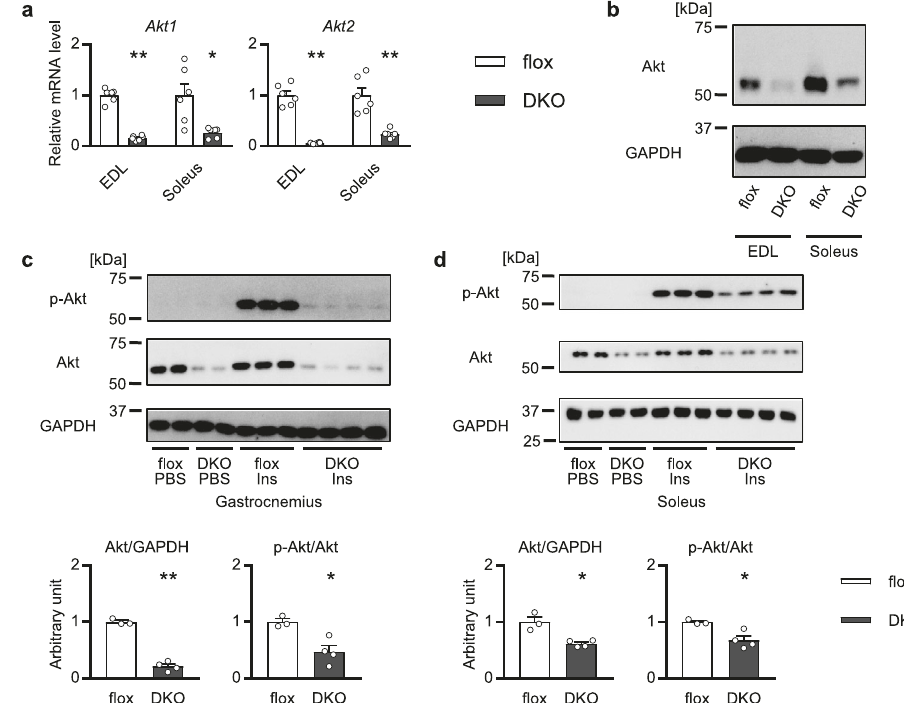
Fig.1 |Generationofskeletalmuscle-speci fi c Akt1 / 2 knockoutmice. Expression of Akt in EDL and soleus of the mAktDKO mice at the age of 8 weeks analyzed by, a RT-PCR ( n =6 mice per group, as shown by the number of data points on the graph, same as below), and b western blotting. c , d Insulin signaling in c gastrocnemius,and d soleus,attheageof8weeksaftertreatmentwithinsulinfor